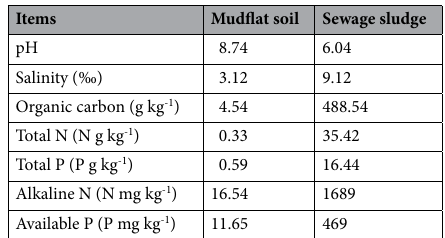
Table 1. Basic properties of the mudflat soil and sewage sludge used in this